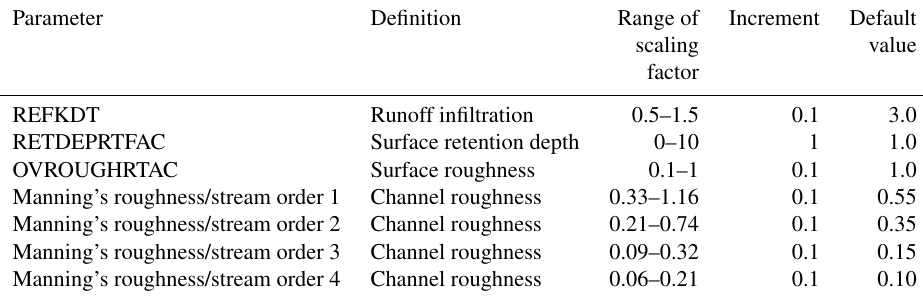
Table 3. The range of calibrated parameters.